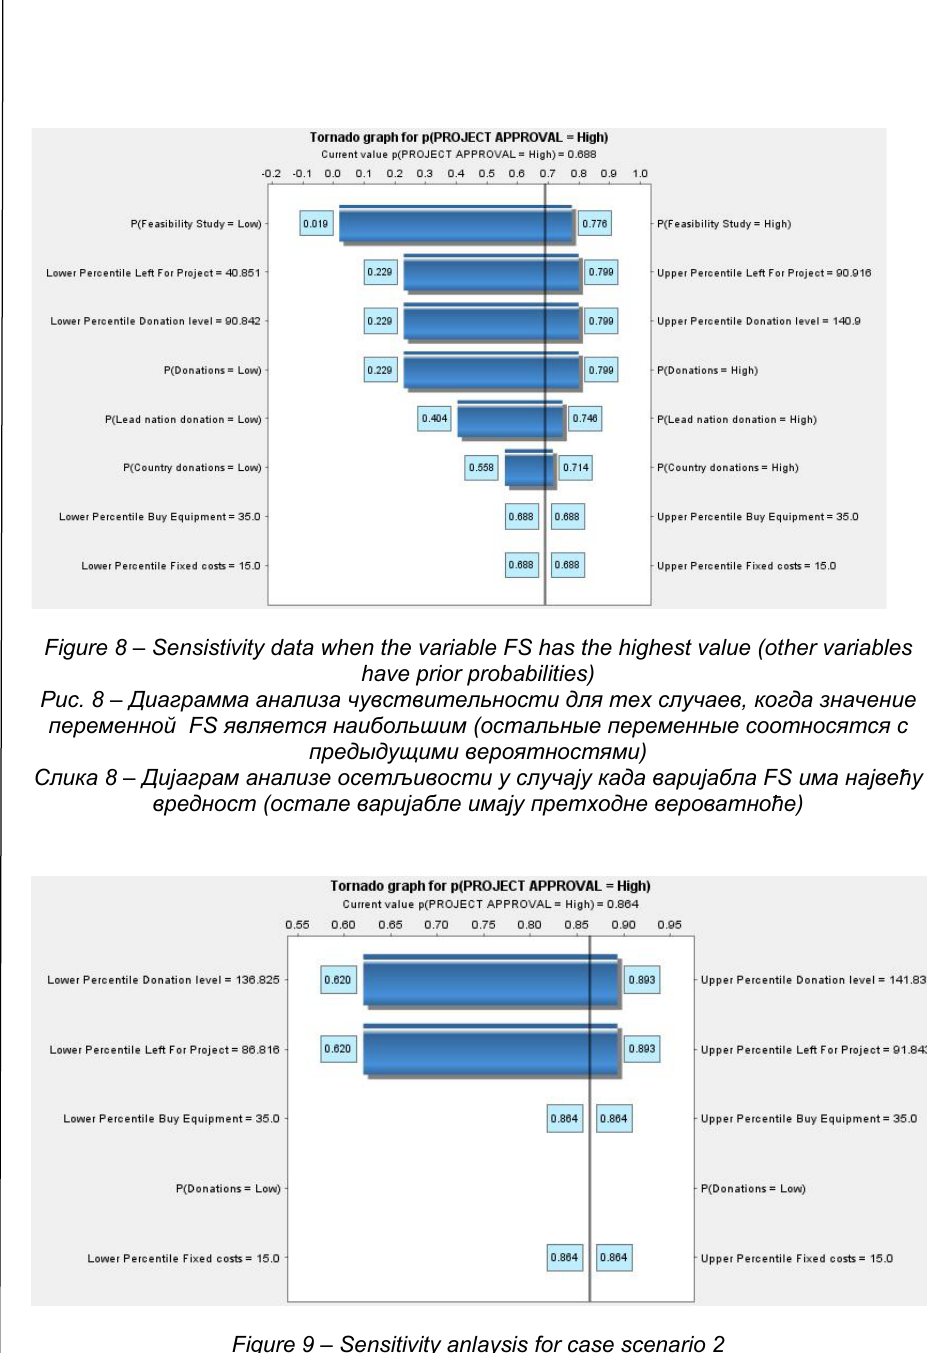
Figure 9 – Sensitivity anlaysis for case scenario